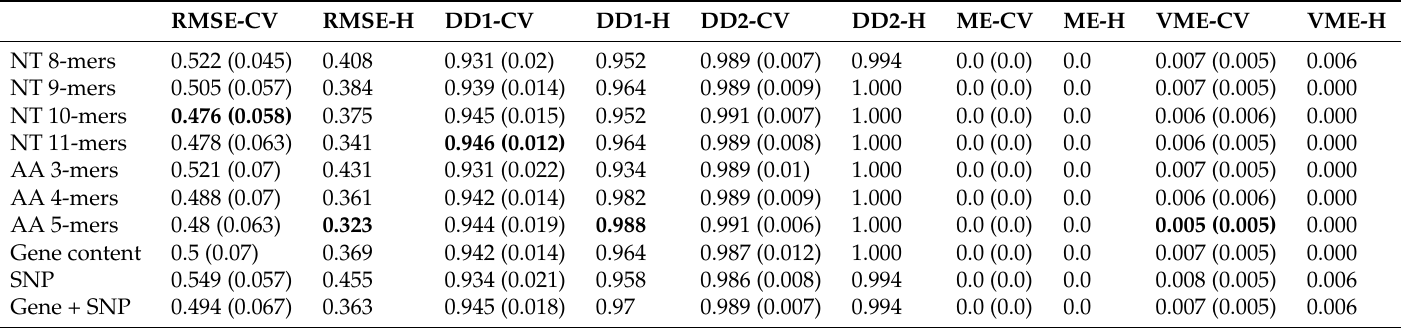
Table A42. K. pneumoniae